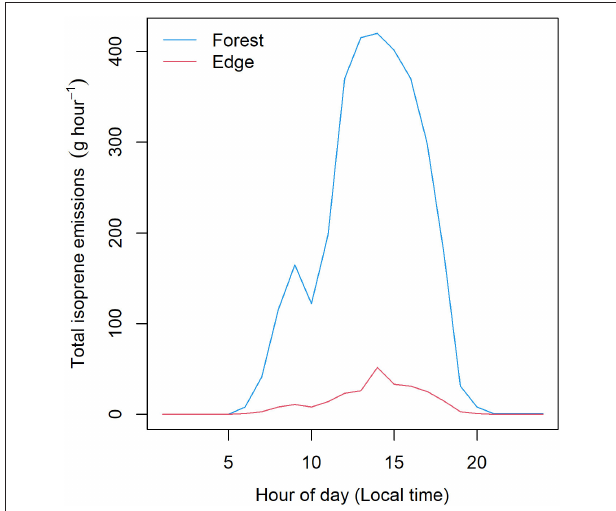
FIGURE 3 | Contributions of edge effect (red line) and forested (blue line) area isoprene emission from the LaBagh Woods study